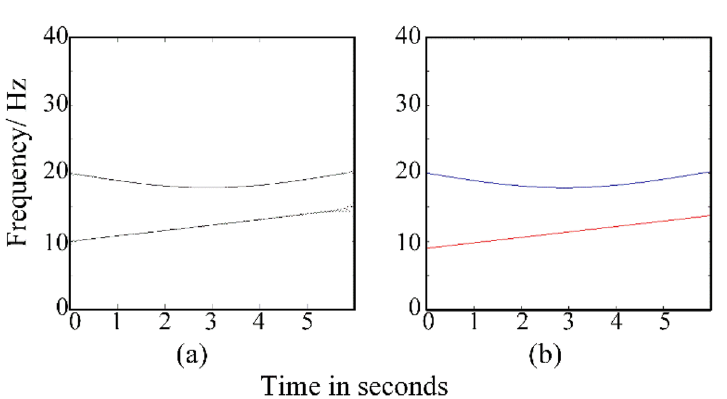
Figure 5. ( a ) The TFR result calculated by GWT–SSET, ( b ) The ideal